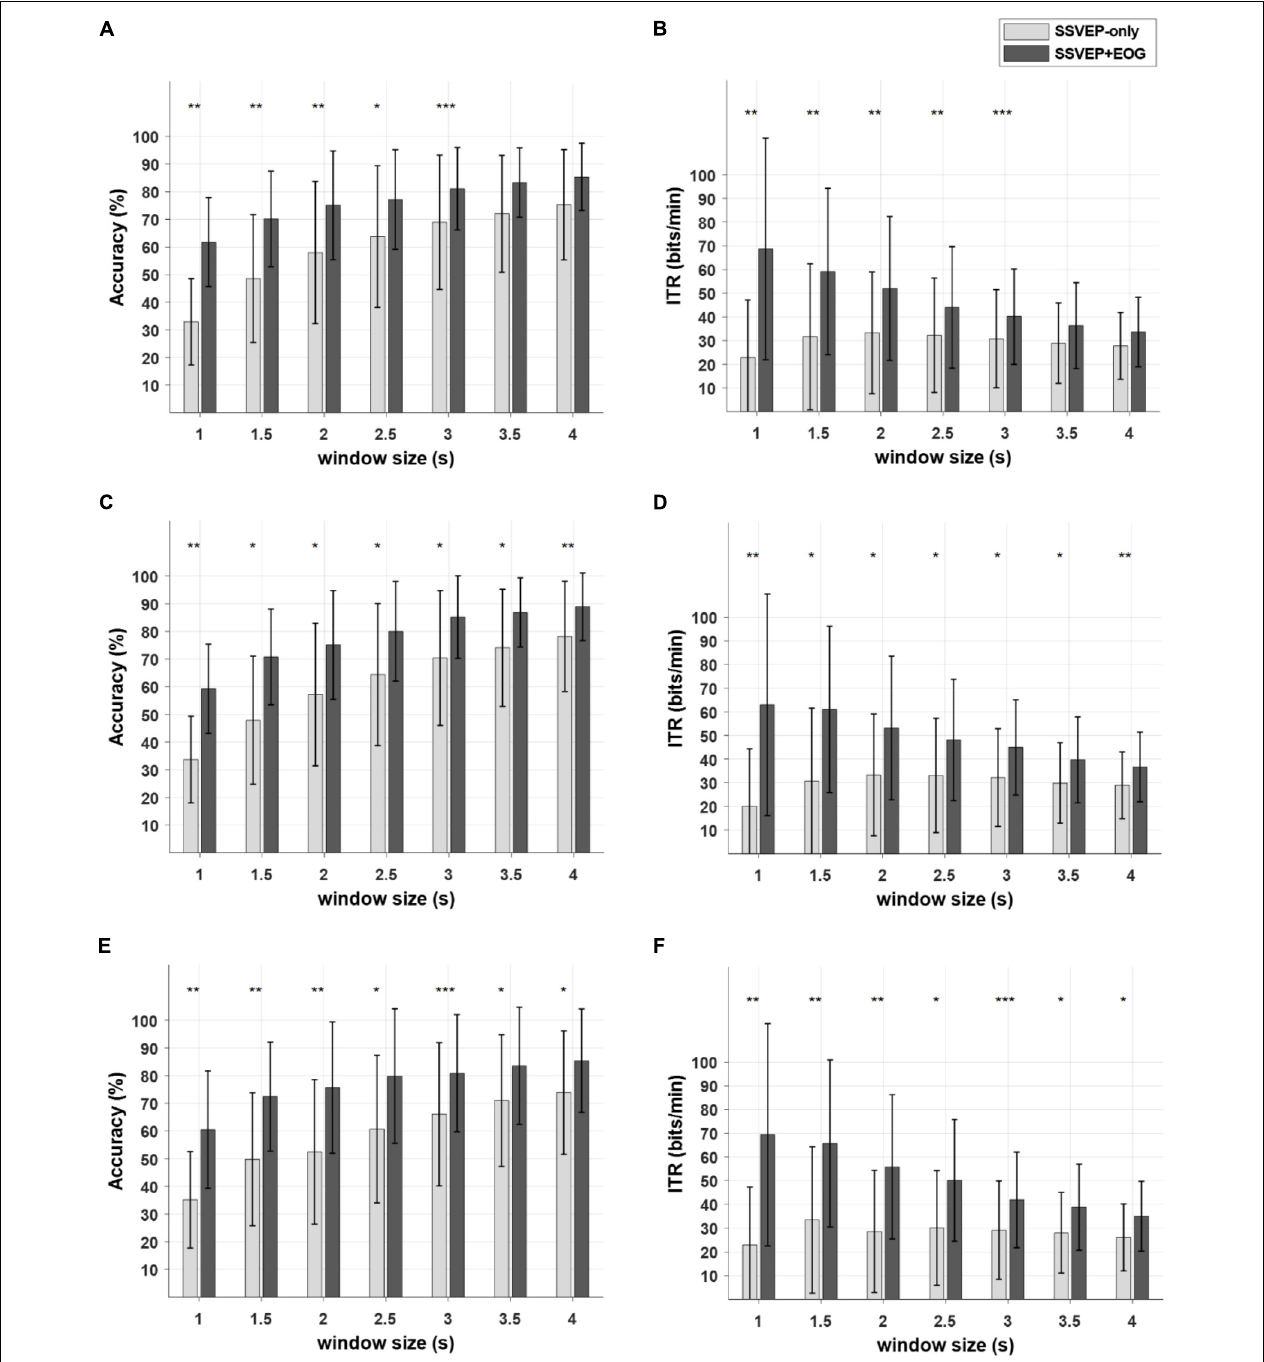
FIGURE 6 | Comparison of the mean classification accuracies and information transfer rates (ITRs) for SSVEP-only and SSVEP+EOG cases with respect to different window sizes. Light gray and dark gray bars indicate SSVEP-only and SSVEP+EOG cases, respectively. Error bars indicate the standard deviation across the participants. (A) the accuracy of the C1, (B) the ITR of C1, (C) the accuracy of C2, (D) the ITR of C2, (E) the accuracy of C3, (F) the ITR of C3. (* p < 0.05, ** p < 0.01, *** p < 0.005, Wilcoxon signed rank test, Bonferroni-corrected).